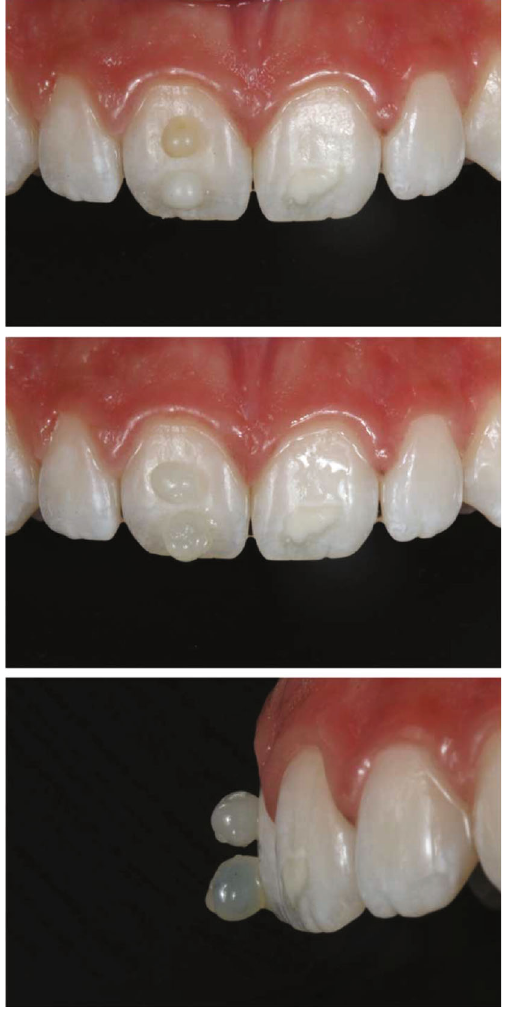
Figure 3: Macroabrasion was performed with high rotation and fi ne diamond tip for fi nishing to remove stains in the form of streaks, super fi cial enamel defects. Positioning of dentin (a) and enamel (b) resin increments on the tooth for color